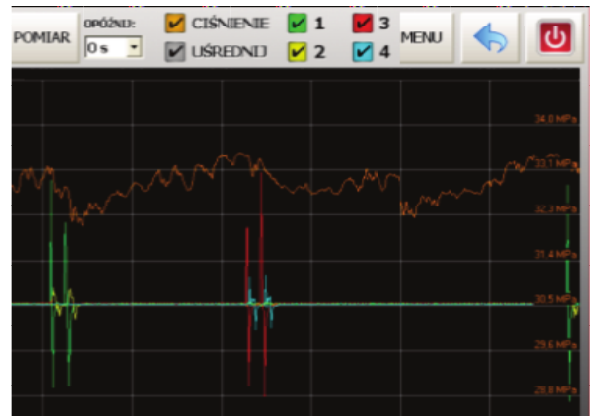
Fig. 6. Current characteristics of injector coils and pressure in the fuel rail.